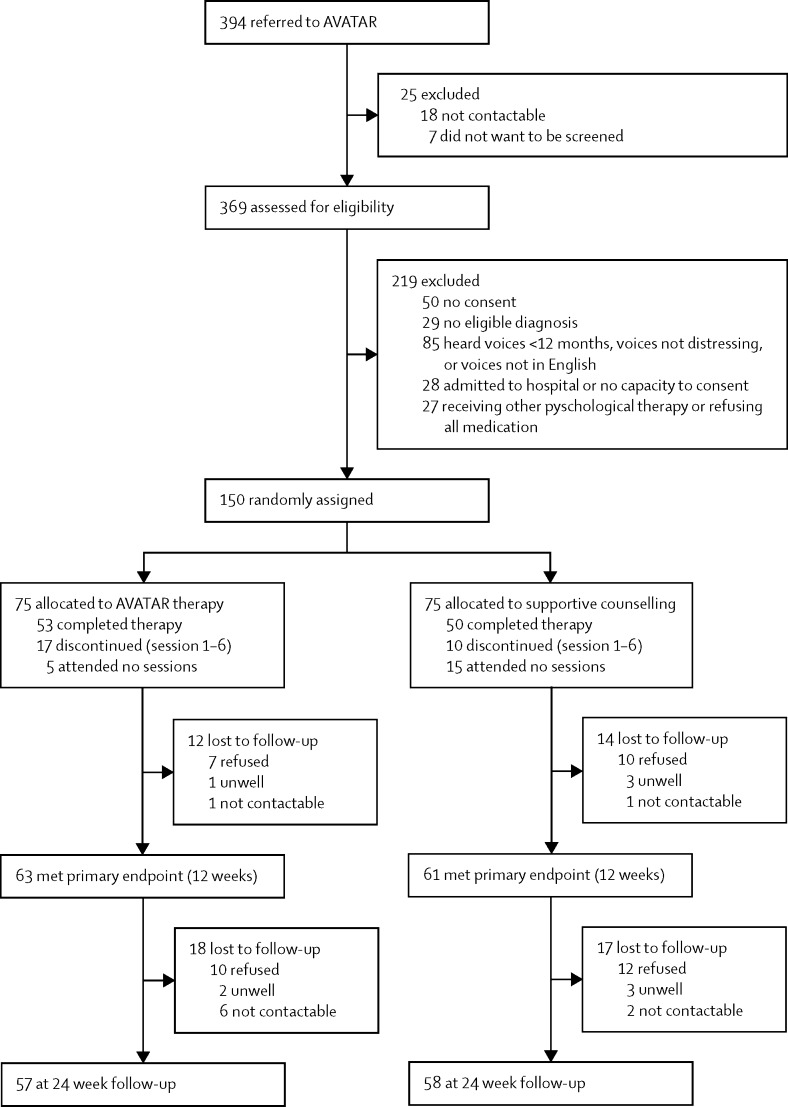
Trial profileNumbers lost to follow-up are cumulative in relation to the total allocated at the start of the study.